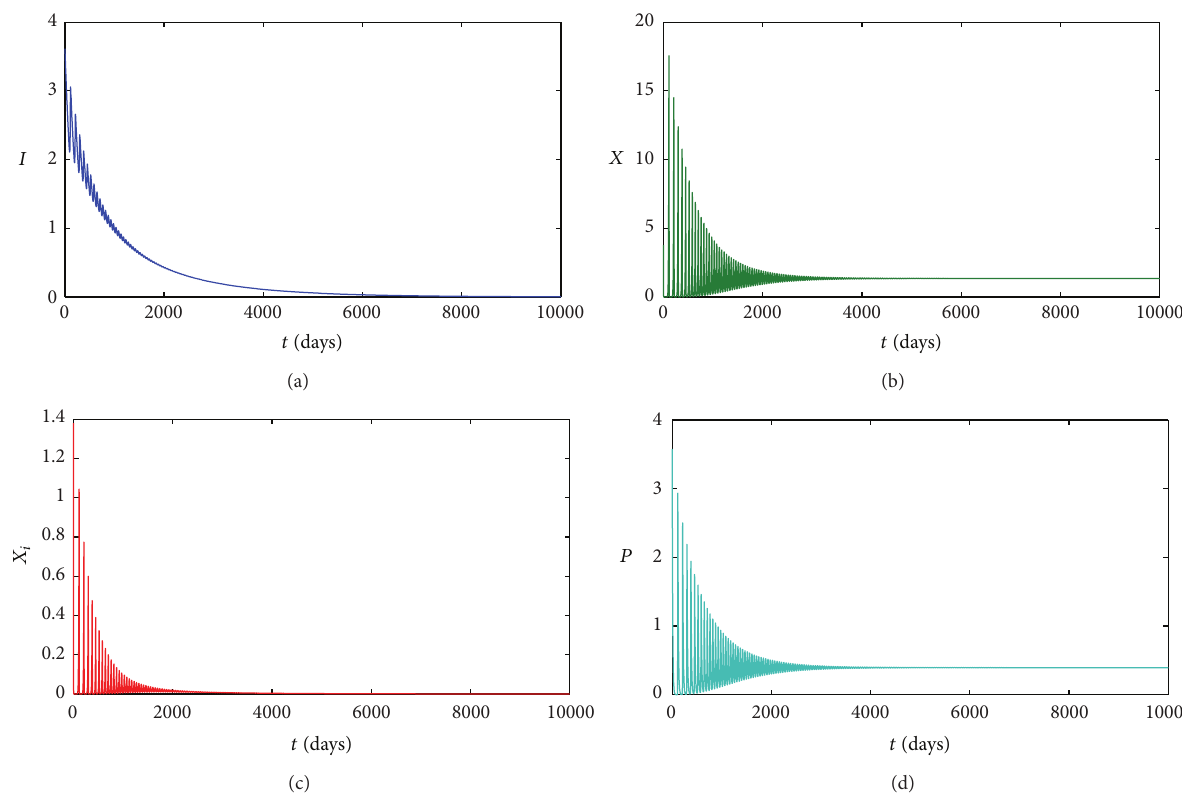
Figure 2: Numerical simulation for Case 1, with 𝑎 = 0.01 , ℎ = 0.5 , and other parameters fixed in Table 1. The vector-borne disease tends to extinct in presence of vector